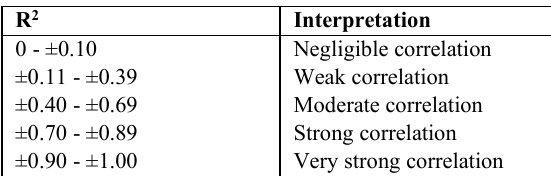
Table 2. Types of sensors and list of extracted WQP from previous research.